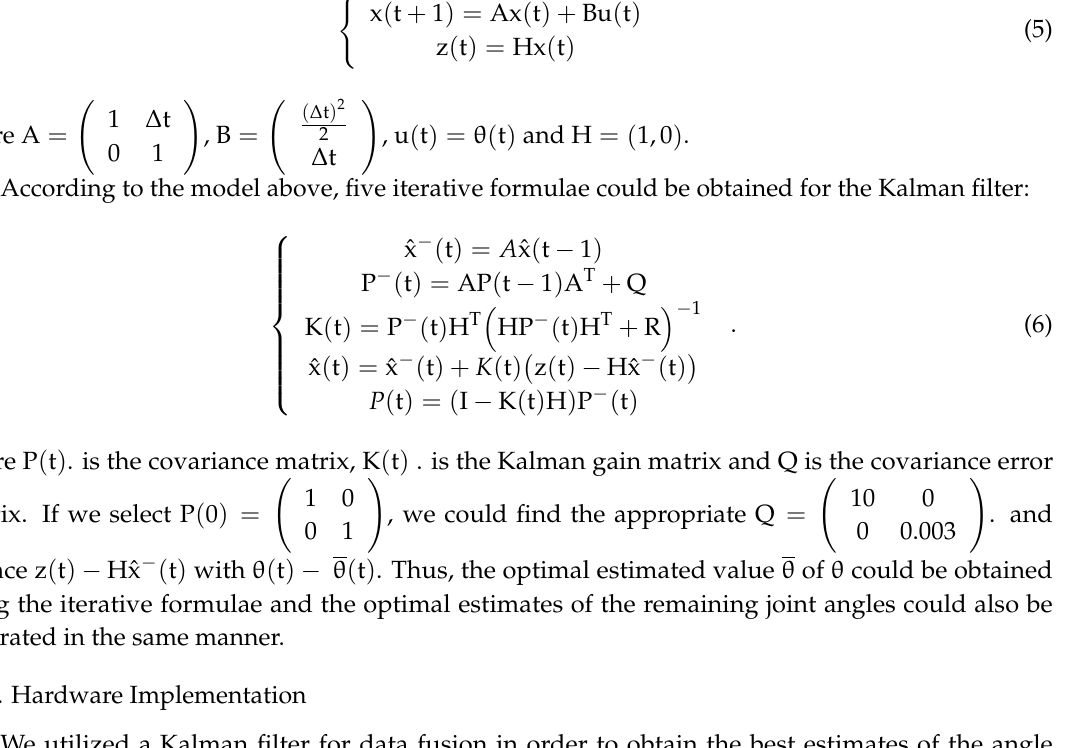
average error was within 1% and thus the error was in an acceptable